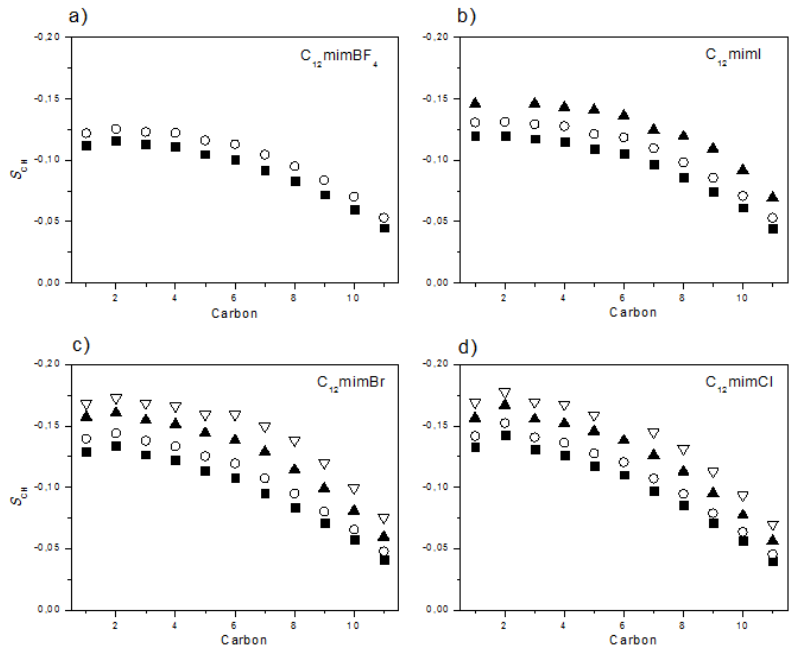
Figure 3. Bond order parameter profiles of four ionic liquid crystals (ILCs) in the smectic A phase at different temperatures. ( a ) C 12 mimBF 4 at 38 °C ( ■ ) and 27 °C ( ○ ). ( b ) C 12 mimI at 55 °C ( ■ ), 44 °C ( ○ ), and 22 °C ( ▲ ). ( c ) C 12 mimBr at 91 °C ( ■ ), 79 °C ( ○ ), 58 °C ( ▲ ), and 35 °C ( ). ( d ) C 12 mimCl at 107 °C ( ■ ), 96 °C ( ○ ), 73 °C ( ▲ ), and 50.5 °C ( ).